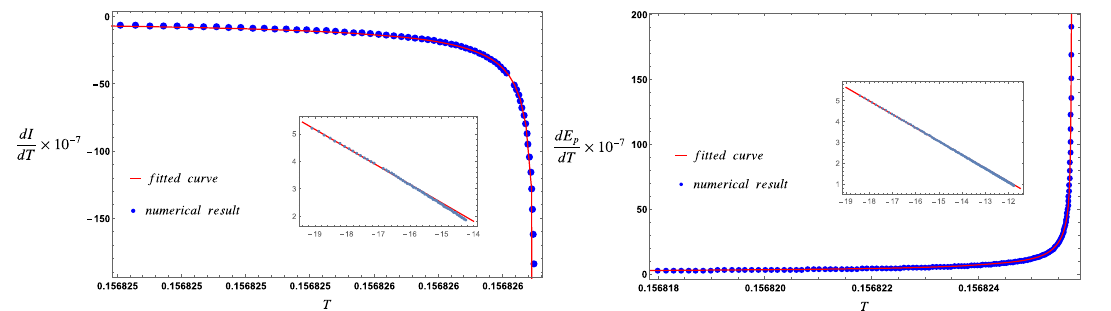
Fig. 10 Left: The slope of I with respect to T for fixed l = 0 . 05 and l (cid:3) = 0 . 01. The fitted curve with the numerical result is dI = − 18289 . 51 t − 0 . 668 . The corresponding RE and RMS are dT 0 . 003 and 0 . 31 respectively. The small plot is the logarithm of the data results and the linear function fitted with them. Right: The slope